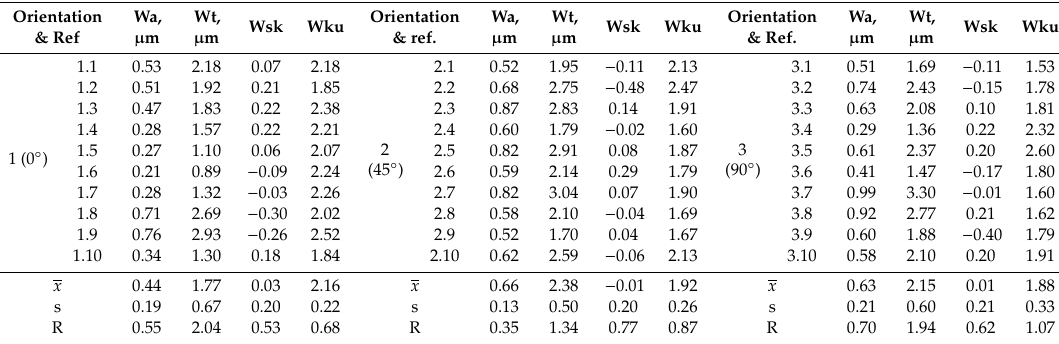
Table 3. Waviness parameters versus orientations for the frontal